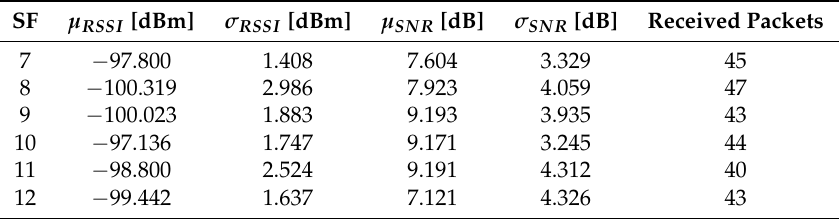
Table 5. Experimental results from group